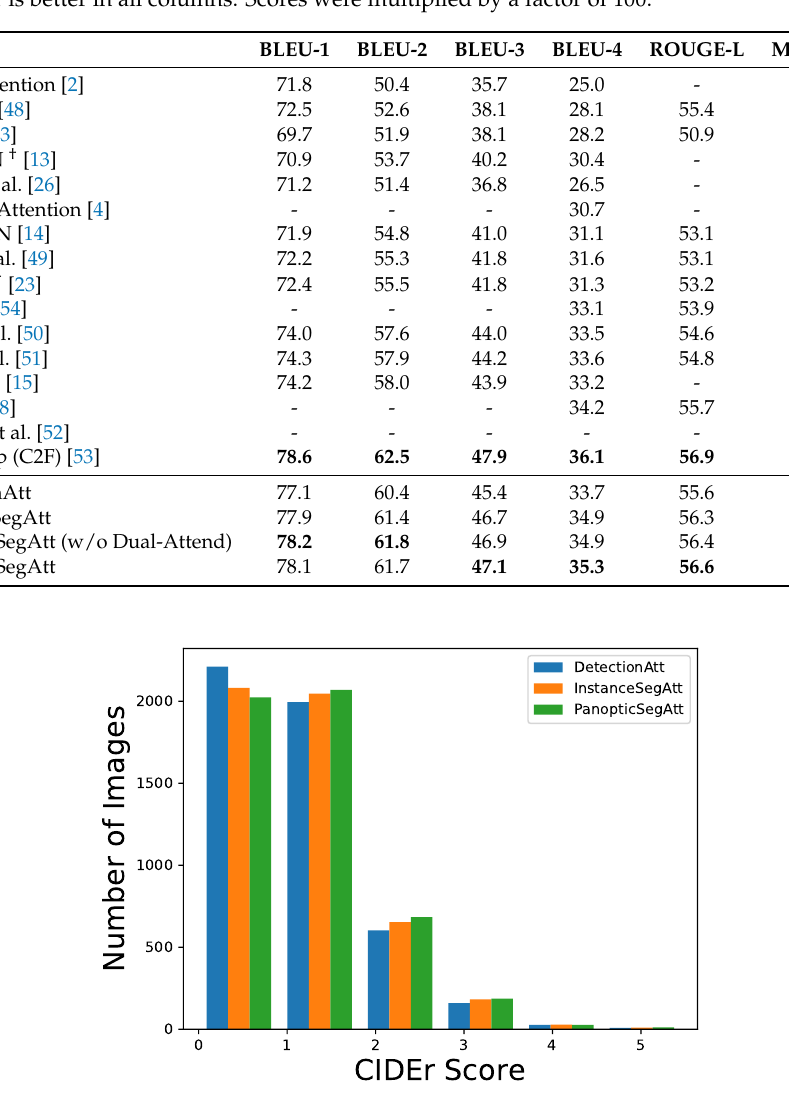
Figure 5. Histogram of CIDEr scores of DetectionAtt, InstanceSegAtt, and PanopticSegAtt.